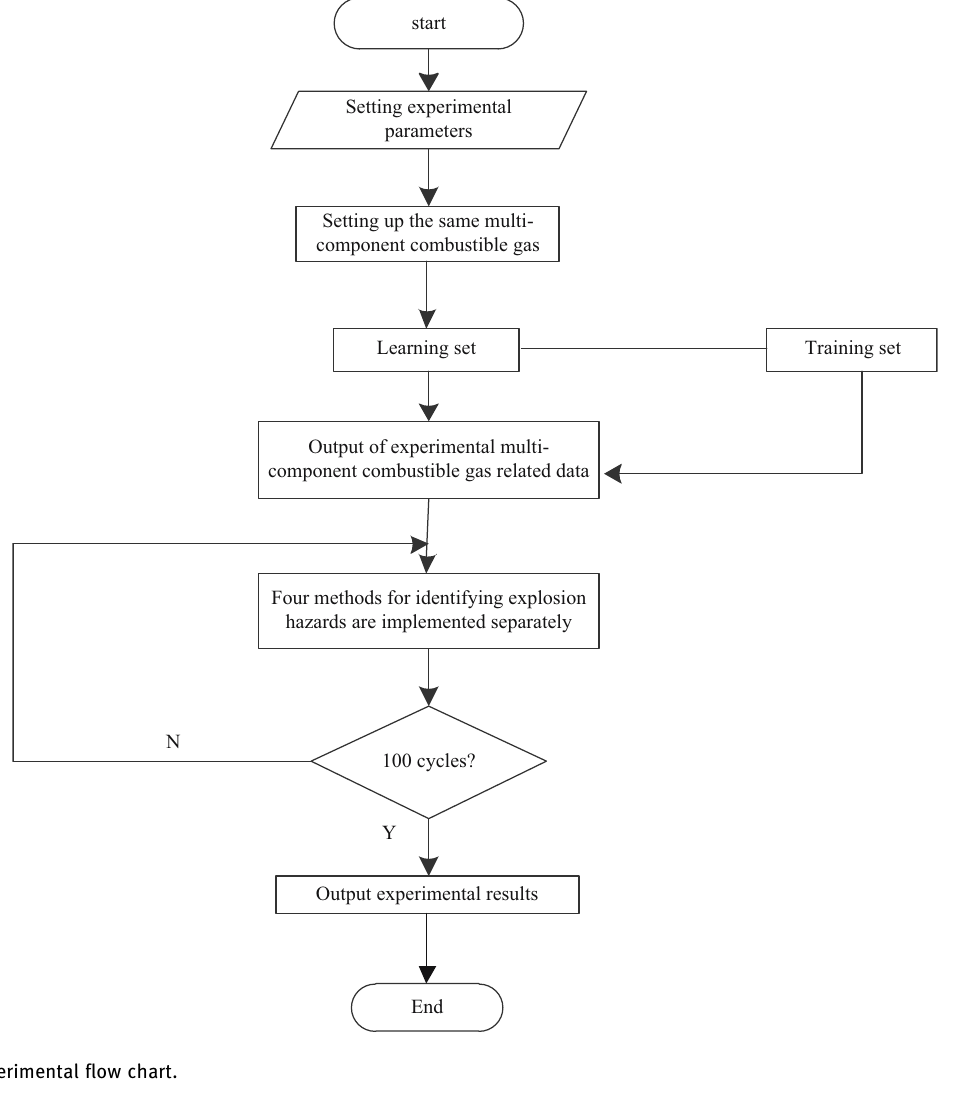
Figure 10: Experimental fl ow